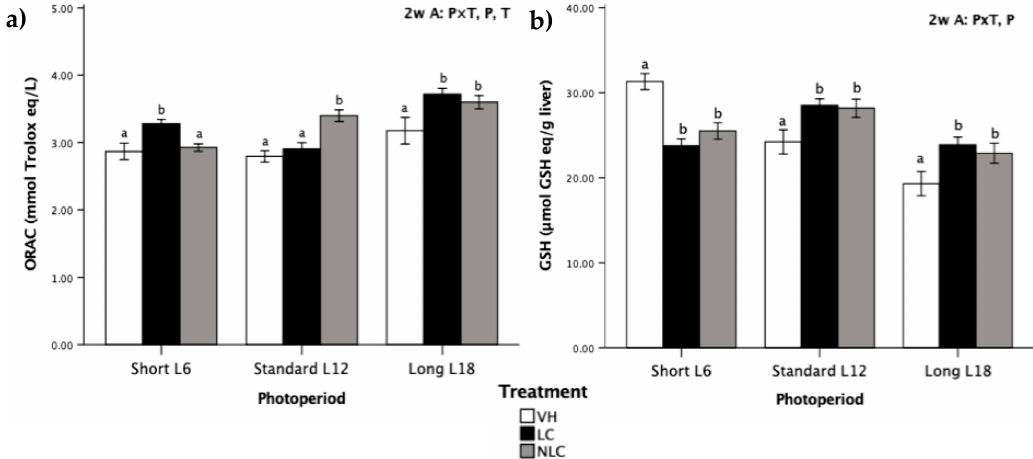
Figure 1. Levels of antioxidant status biomarkers in Fischer 344 rats exposed to three different photoperiods for 7 weeks and supplemented with local sweet cherry (LC), non-local sweet cherry (NLC), or vehicle (VH): ( a ) oxygen radical absorbance capacity (ORAC); ( b ) reduced glutathione (GSH) concentration. Data are expressed as the mean ± SEM ( n = 8). Two-way ANOVA was performed to evaluate the differences between the groups, thus we could determine the effects of the photoperiod, P; the treatment, T; or the photoperiod × treatment interaction, P × T. Later on, one-way ANOVA was used to evaluate significant differences among the treatments (LC, NLC, and VH) within each photoperiod exposure (Short L6, Standard L12, and Long 18); these differences are indicated with different letters. Abbreviations: L6: 6 h light/day, L12: 12 h light/day, L18: 18 h light/day, ANOVA: analysis of variance.